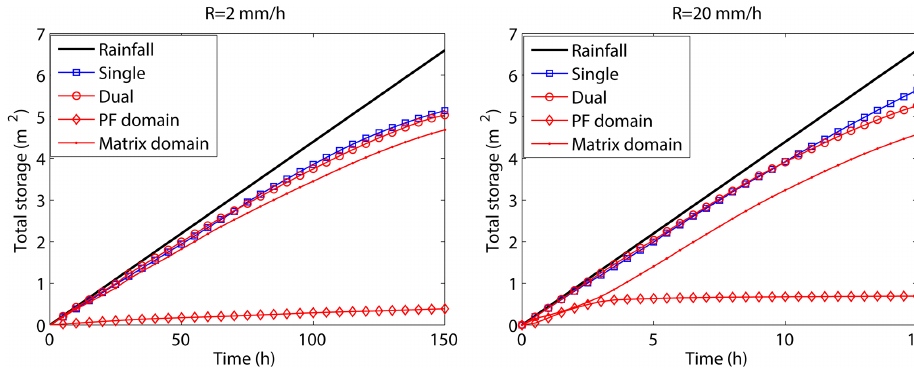
Figure 6. Storage increase of single-permeability model and dual-permeability model.